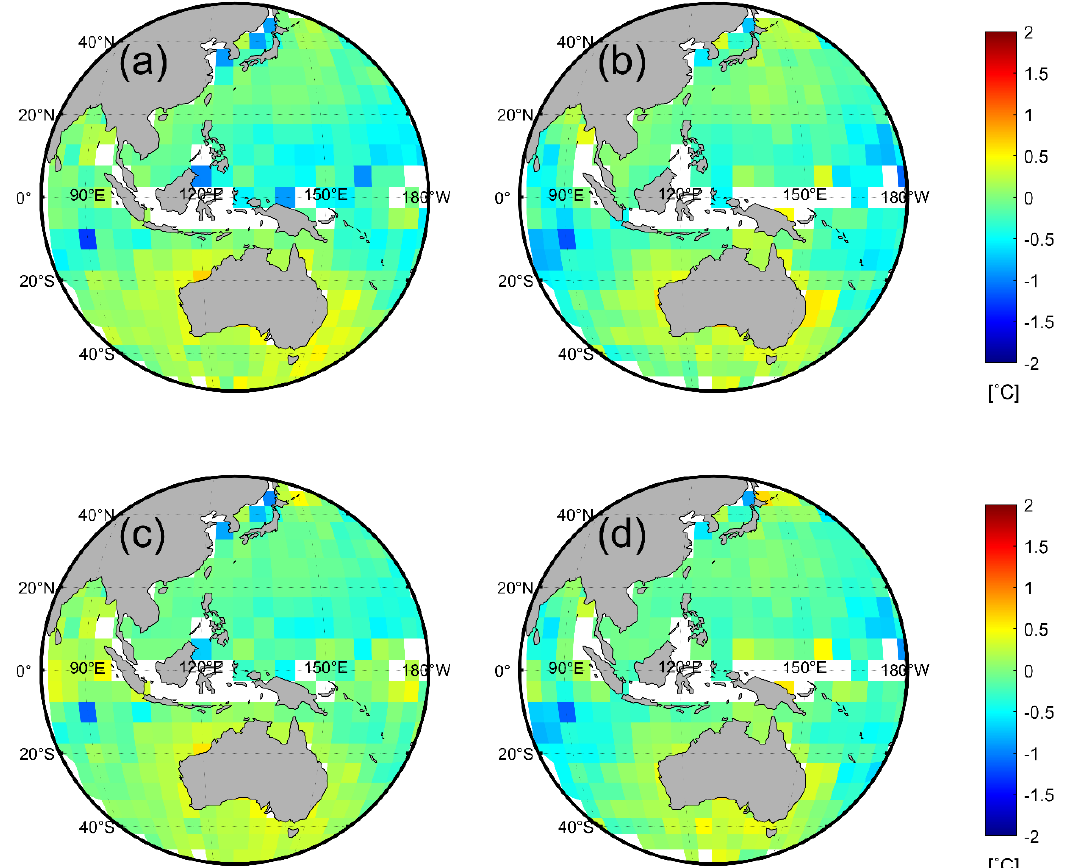
Figure 6. Spatial distribution of mean differences between MCSSTs and in situ temperatures for the ( a ) daytime and ( b ) nighttime and between NLSSTs and in situ temperatures in the ( c ) daytime and ( d ) nighttime in bins of 5° × 5° for the period from April 2011 to March 2014.